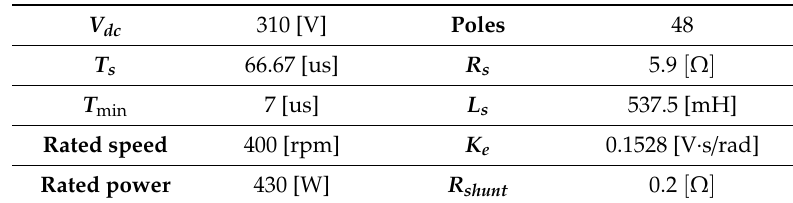
Table 3. Parameters of the system.